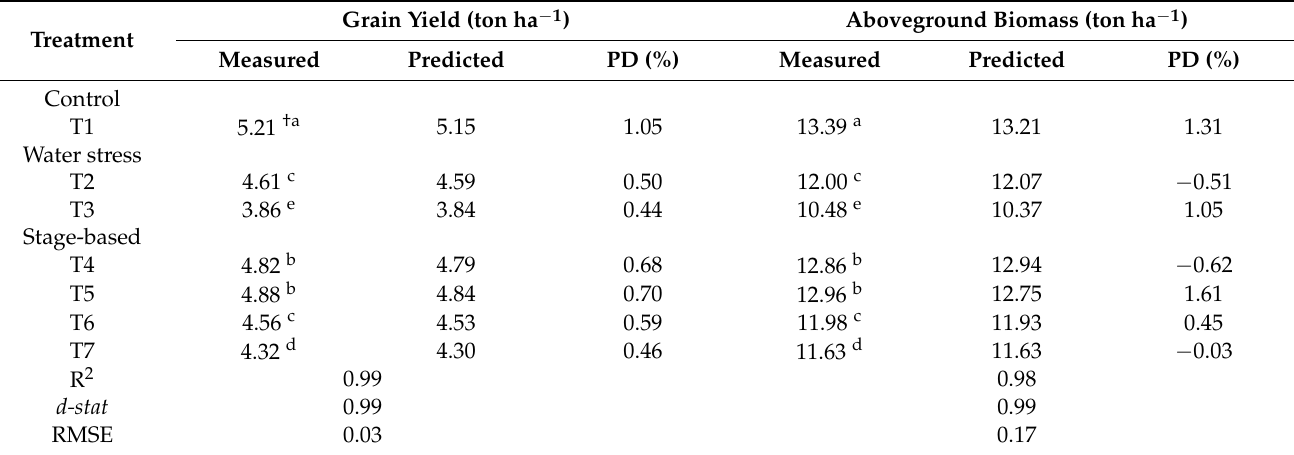
Table 7. Measured versus predicted wheat grain and aboveground biomass, and percentage of the difference between measured and predicted values (PD%) under the studied irrigation treatments in the calibration